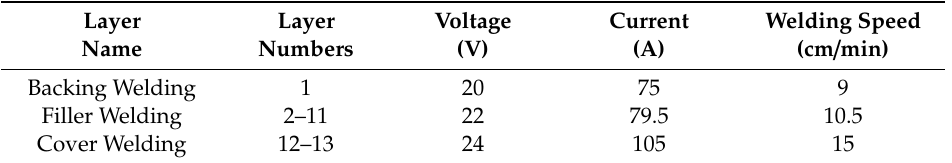
Figure 3. The investigated welded joint. Table 1. Welding parameters of the undermatched welded joint adapted from [18], with permission from American Society of Mechanical Engineers, 2019.